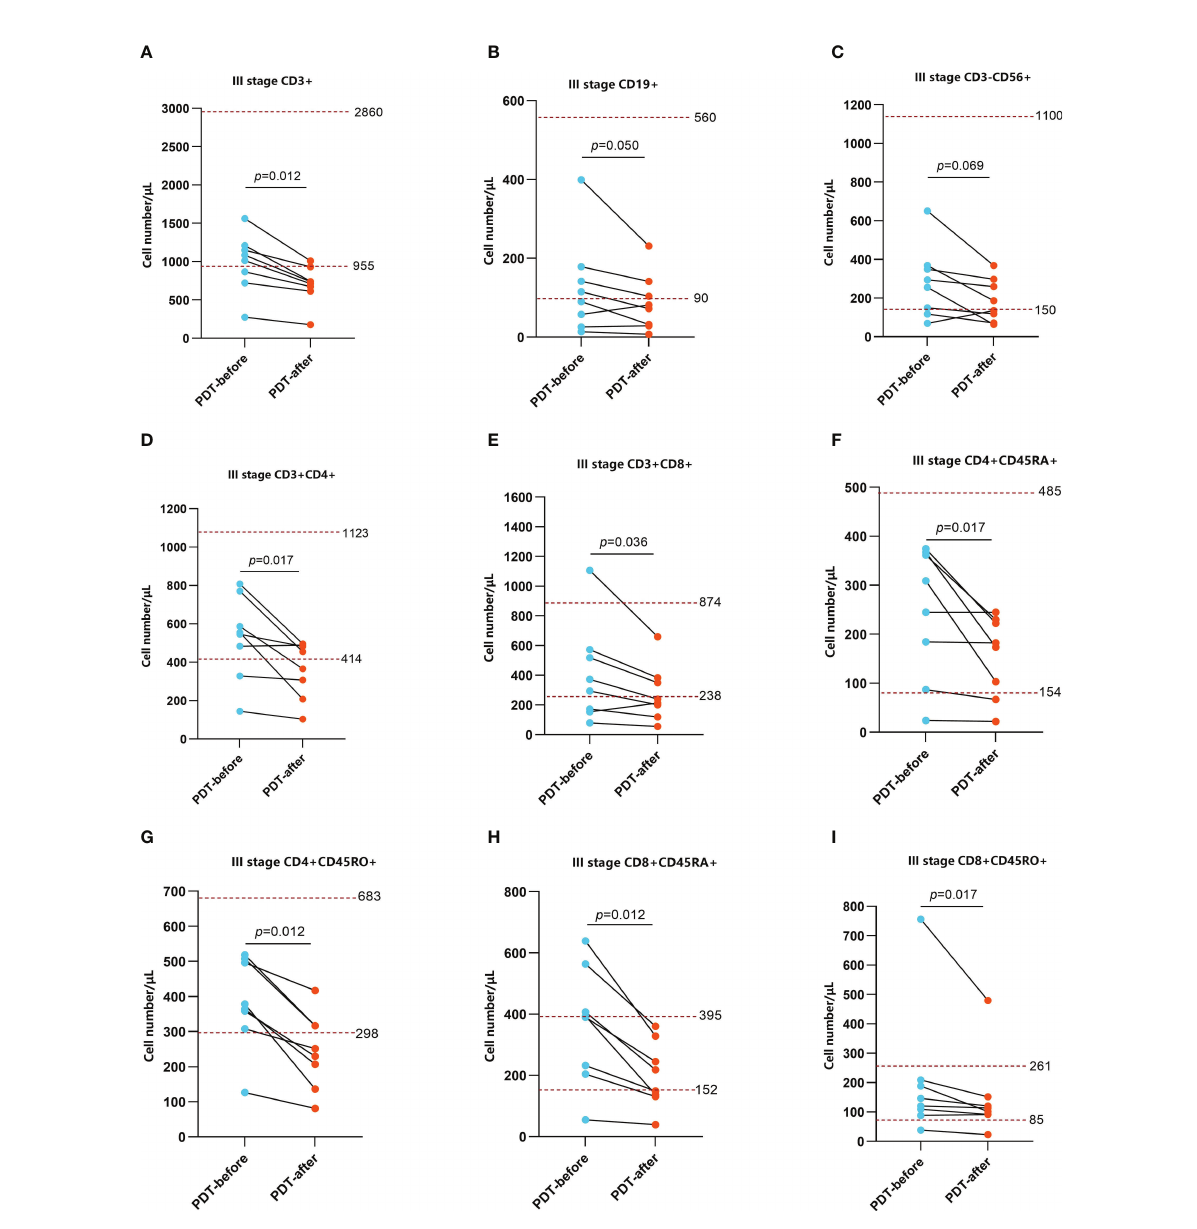
FIGURE 4 Changes in peripheral blood immune function before and after 48h of PDT in stage III CRC patients (n=8). The number of CD3 + T cells, CD3 + CD4 + T cells, CD3 + CD8 + T cells, CD4 + CD45RA + T cells, CD4 + CD45RO + T cells, CD8 + CD45RA + T cells, CD8 + CD45RO + T cells were basically at a normal level before PDT but signi fi cantly decreased at 48h after PDT (A, D, E – I) . CD19 + B cells and CD3 - CD56 + NK cells were at lower than normal levels. Although there was no statistical difference in CD cells, the overall trend was still downward (B, C)